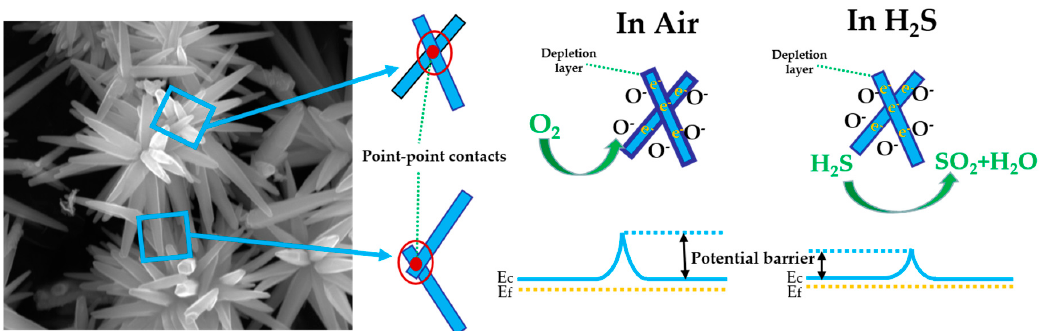
Figure 9. Schematic diagram of ZnO HS2 gas sensitivity mechanism.